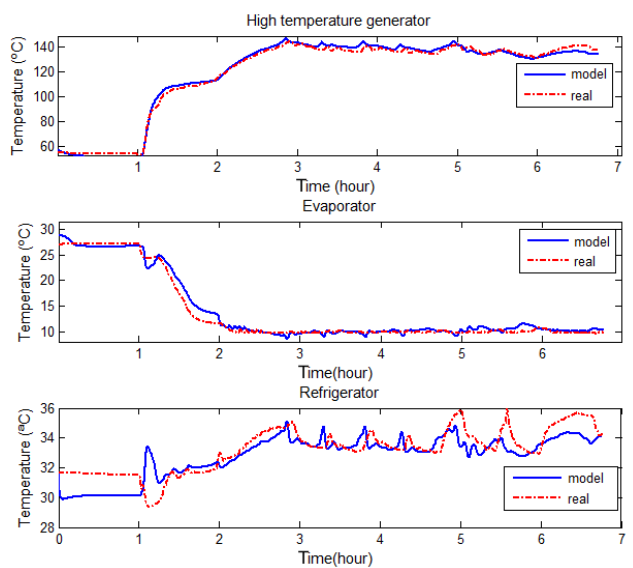
Figure 8. Absorption machine model vs. real: 21 July